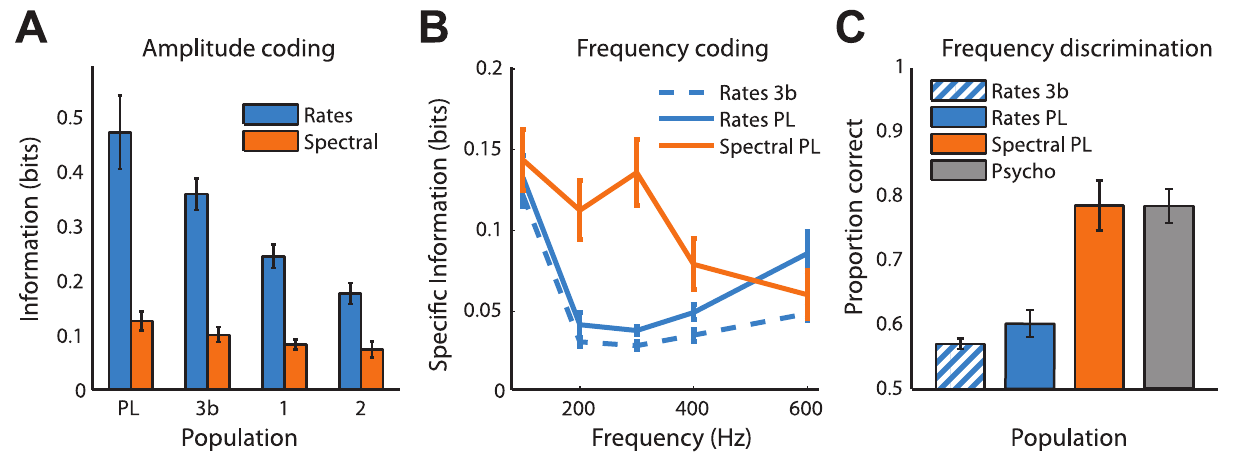
Figure 5. Multiplexing of stimulus information. (A) Mean mutual information between stimulus amplitude and firing rates (blue) and between stimulus amplitude and spectral peak (orange), computed from the responses of PL neurons, and neurons in areas 3b, 1, and 2. (B) Mean specific information about stimulus frequency conveyed in the response rates and timing of S1 neurons. (C) Performance on a frequency discrimination task (300 Hz versus 200 or 400 Hz) predicted from the firing rates of individual neurons in area 3b, from the rates of individual PL neurons (blue), and from the spectral peak of the responses of PL neurons (orange). Performance of human subjects is shown in grey. Error bars denote the standard error of the mean on all panels.